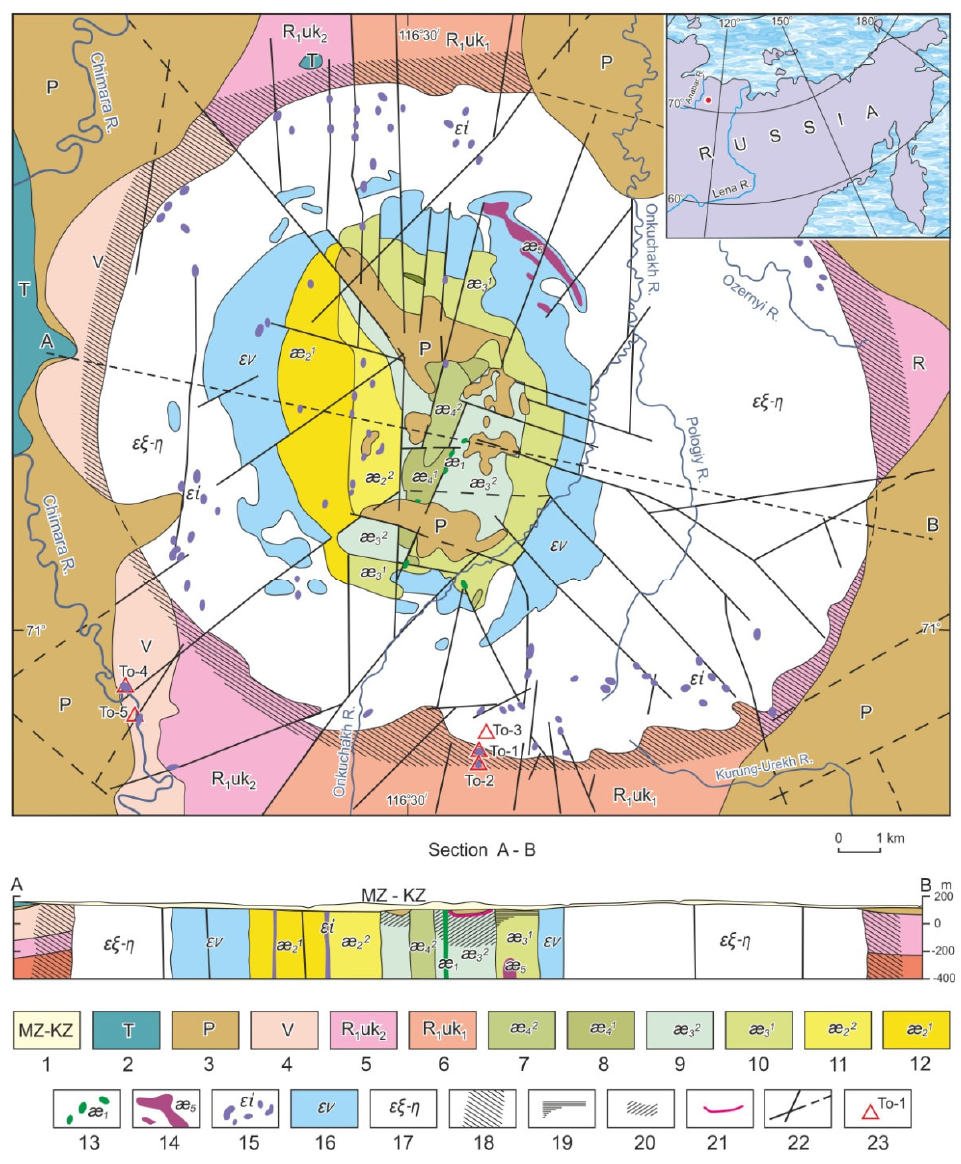
Figure 1. Schematic geological map of the Tomtor massif without Mesozoic–Cenozoic overlapping cover. Composed on geological base compiled by A.V. Tolstov [8] based on materials from a geo ‐ logical survey (1974–1983) and the results of the Ebelyakh GSP. In the inset, the Tomtor massif is marked with a red circle. 1—Mesozoic–Cenozoic silt ‐ shales, sandstones, undivided gravelites